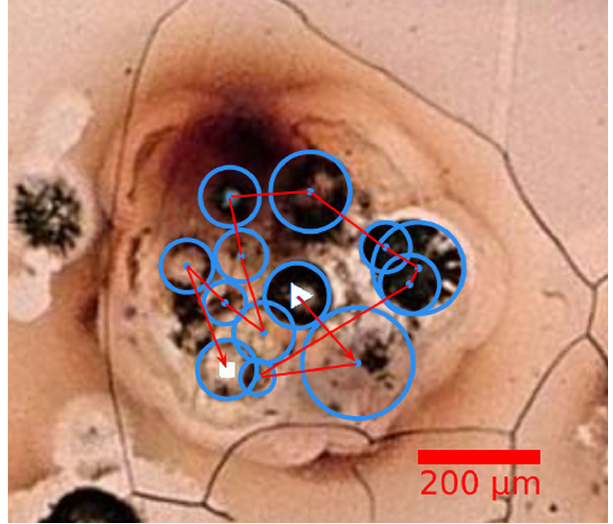
FIG. 12. Optical microscope image of a series of 13 consecutive soft copper BDs in a cluster on, bounded by a grain on a soft copper surface. White triangle and square indicate the first and last BDs, respectively. The circle edges and centers were identified manually as the machine vision algorithm was not usable due to lack of contrast. The order of the BD sequence was obtained from the BD localization information. between. Figure 12 shows an example of a series of 13 consecutive BDs (including some ramping BDs) within one grain.